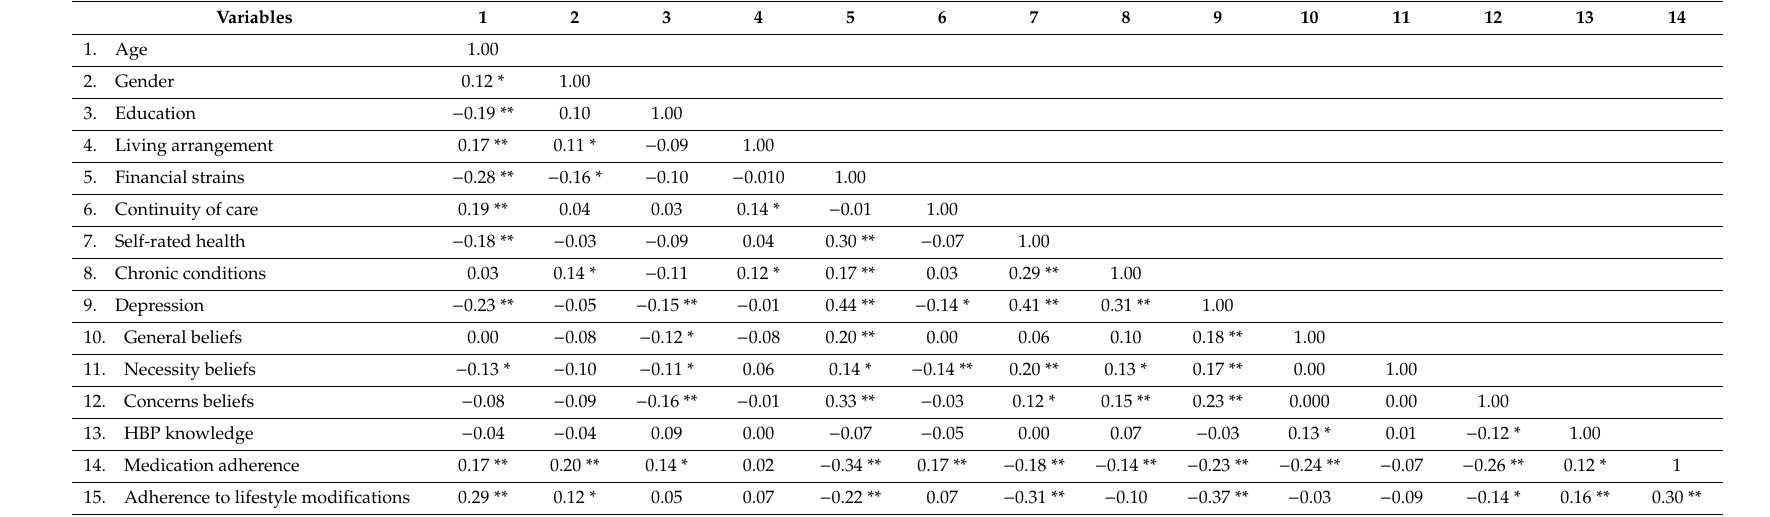
Table 2. Bivariate correlations between all